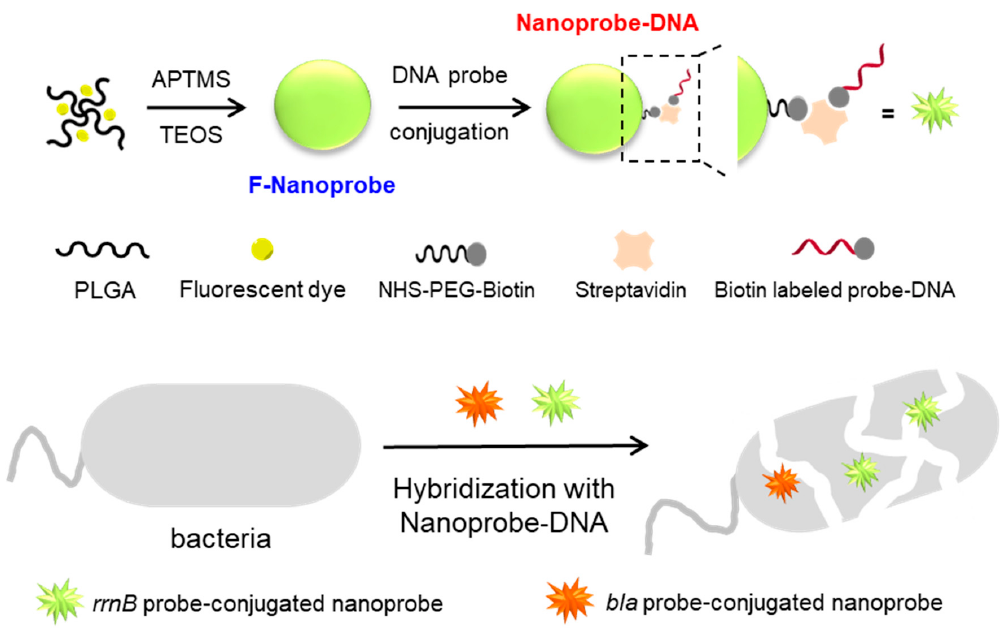
Figure 1. Schematic illustration of preparation of stable nanoprobe-DNA for FISH.